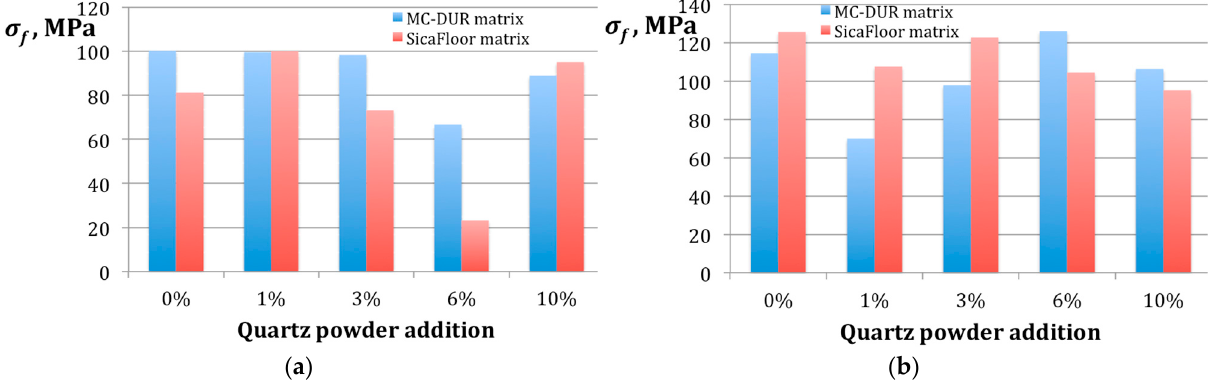
Figure 8. The results of the flexural strength σ f measurement for the specimens of the different particulate filler proportions in the polymer matrices MC-DUR 1200VK and Sikafloor 156, pro- duced using different binders: ( a ) with the emulsion binder; ( b ) with the powder